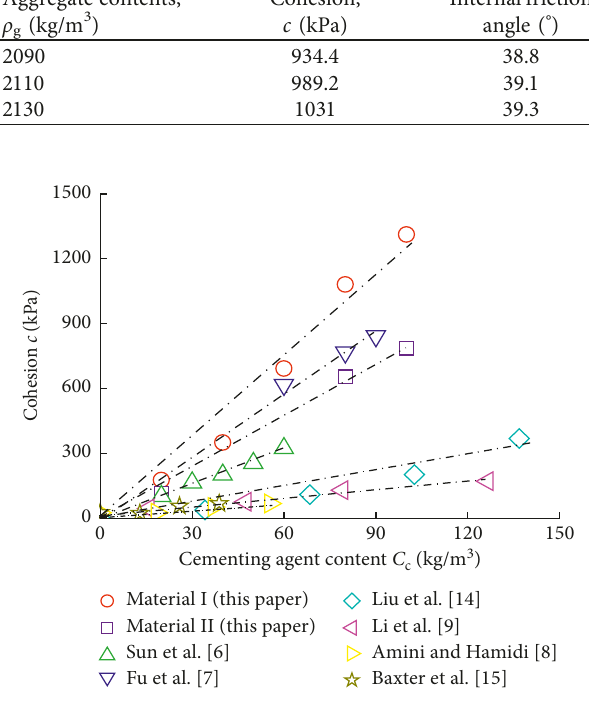
Figure 9: Relation between cohesion and cementing agent content.